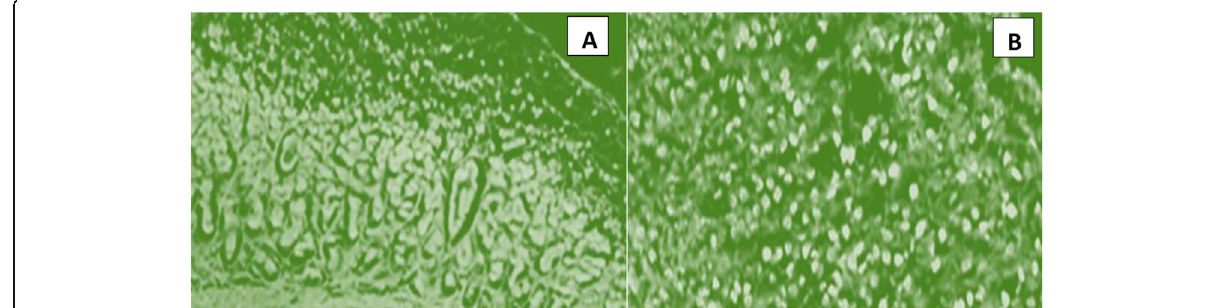
Fig. 10 A Fluorescent image of colonic mucosa without formulation. B Fluorescent image of colonic mucosa showing mucoadhesion of optimized Nanoparticulate formulation